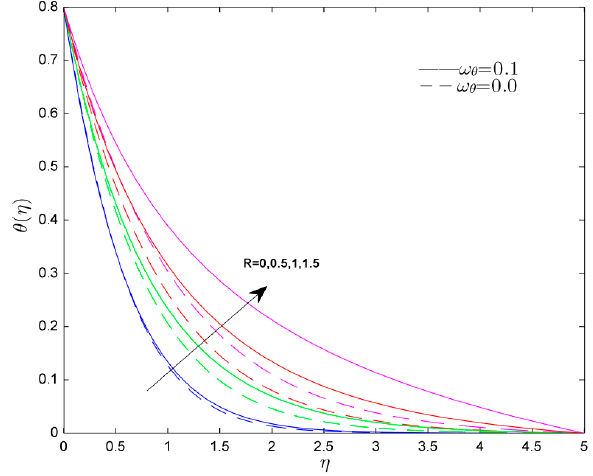
Figure 11. Effect of thermal radiation parameter (𝑅) on 𝜃(𝜂) .